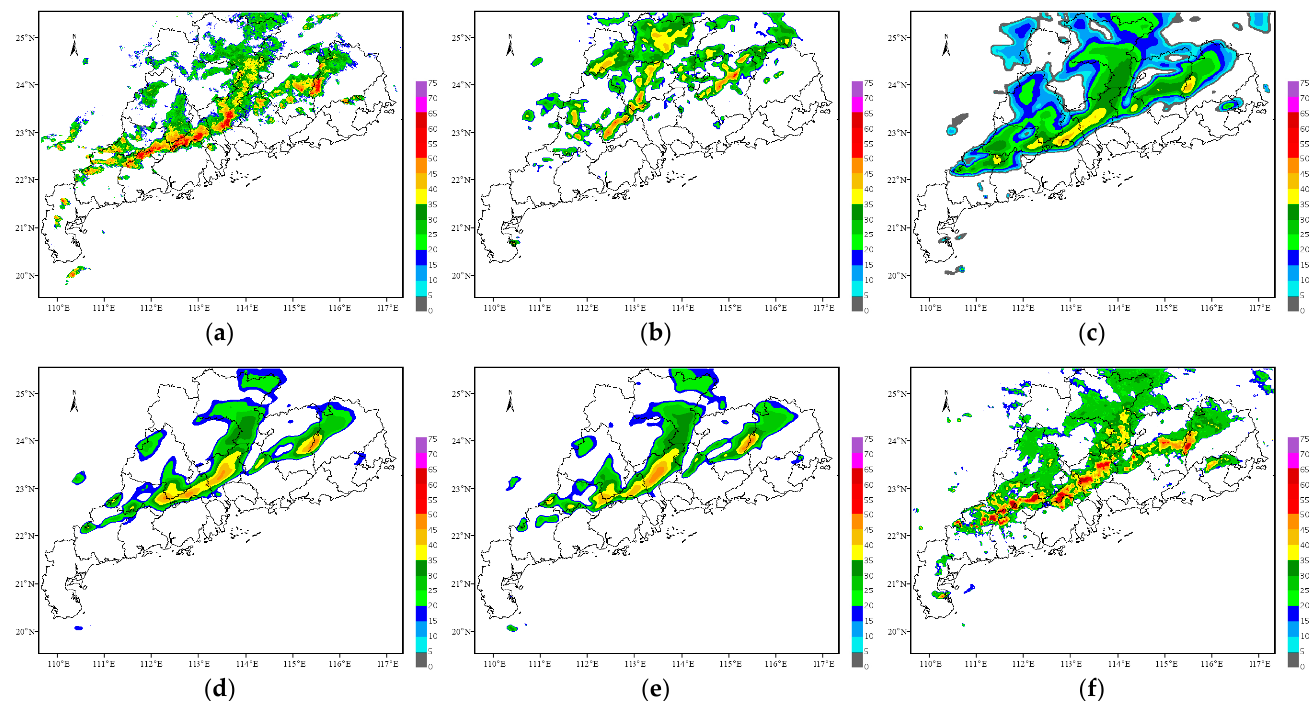
Figure 5. Nowcasting results of the squall line process for the next 1 h. ( a ) Observation; ( b ) Opti- calflow; ( c ) ConvGRU; ( d ) PredRNN; ( e ) PredRNN V2; ( f )